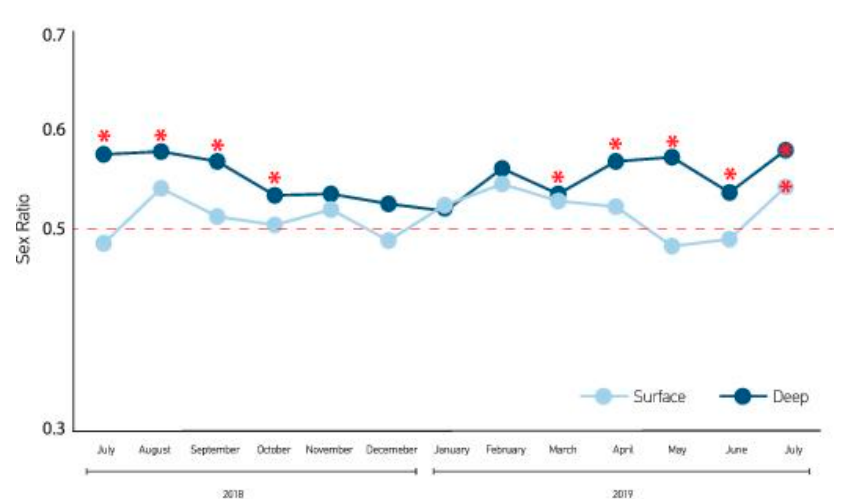
Figure 6. Temporal variation of Sex ratio of the surface and deep population of Caprella scaura from a fish farm in the Pagasitikos Gulf. Red asterisks (*) indicate deviation from 1:1. Values over the dashed line indicate female dominance, whereas values below the dashed line indicate male dominance.